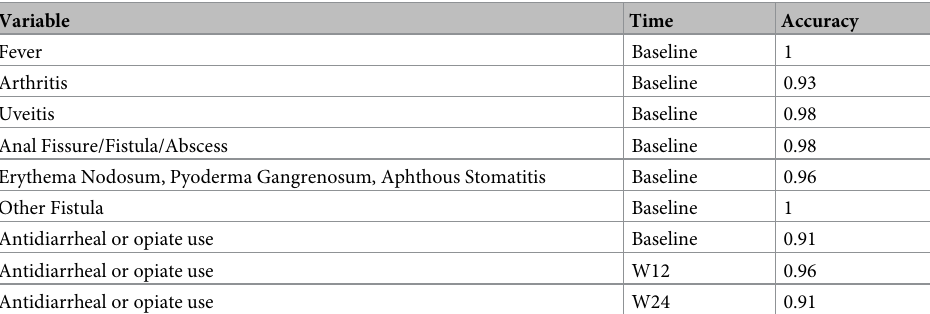
Table 2. Comparison of the results of non-PRO3, binary CDAI elements by manual vs informatics methods. Accuracy is reported relative to manually abstracted data (gold-standard). W12 and W24 correspond to the week 12 and 24 periods respectively. Comparisons were made against the annotations performed by one chart reviewer (45 patients), roughly a quarter of the 183 patients who met all eligibility criteria prior to application of the baseline CDAI